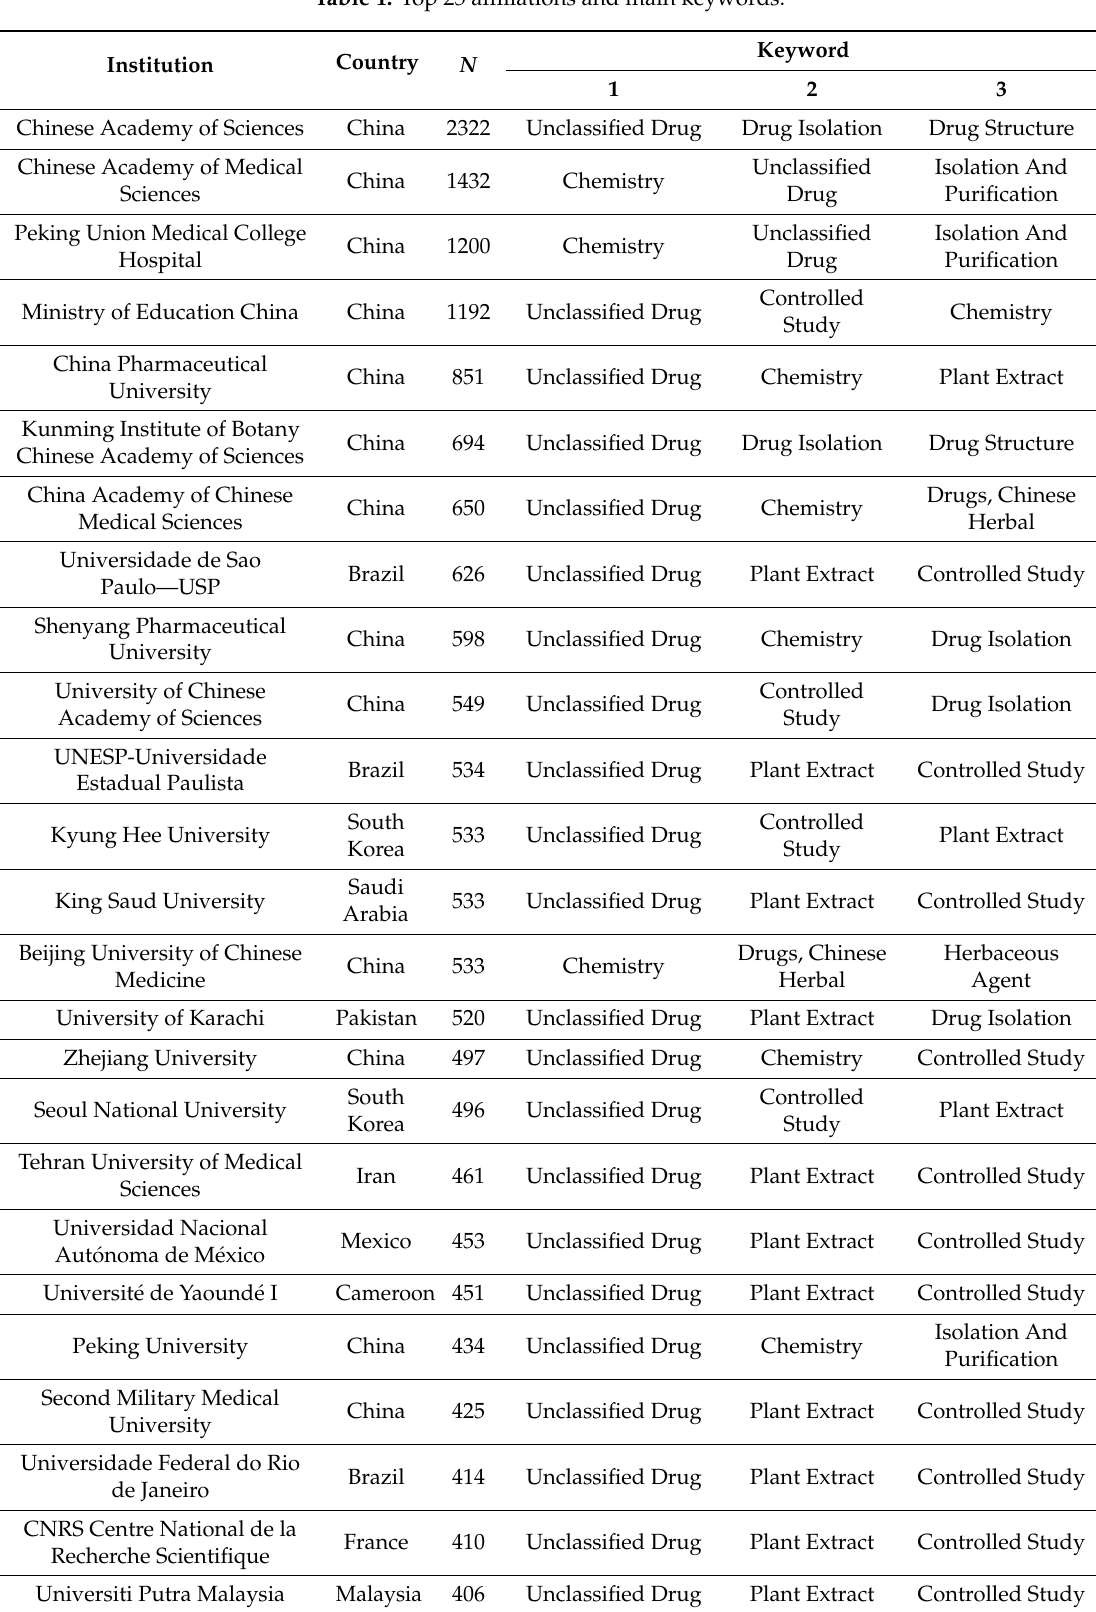
Table 1. Top 25 a ffi liations and main